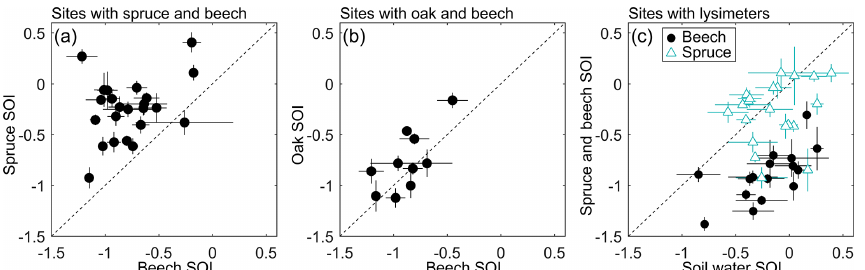
Figure 5. Pairwise comparisons of seasonal origin index values for sites where (a) spruce and beech are collocated, (b) oak and beech are collocated, and (c) trees and lysimeters are collocated. The 1 : 1 lines are plotted for reference, highlighting that (a) spruce used more summer-sourced water than beech, whereas (b) beech and oak used similar water supplies. Additionally, (c) spruce used water similar to lysimeter soil water, unlike beech. Symbols indicate site means with error bars representing 1 standard error of the mean, attributable to intra-site